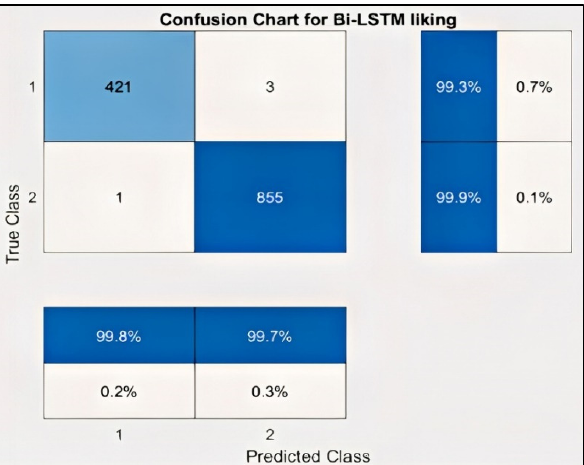
Figure 20. Confusion chart for Liking label. Table 6. Liking label results.